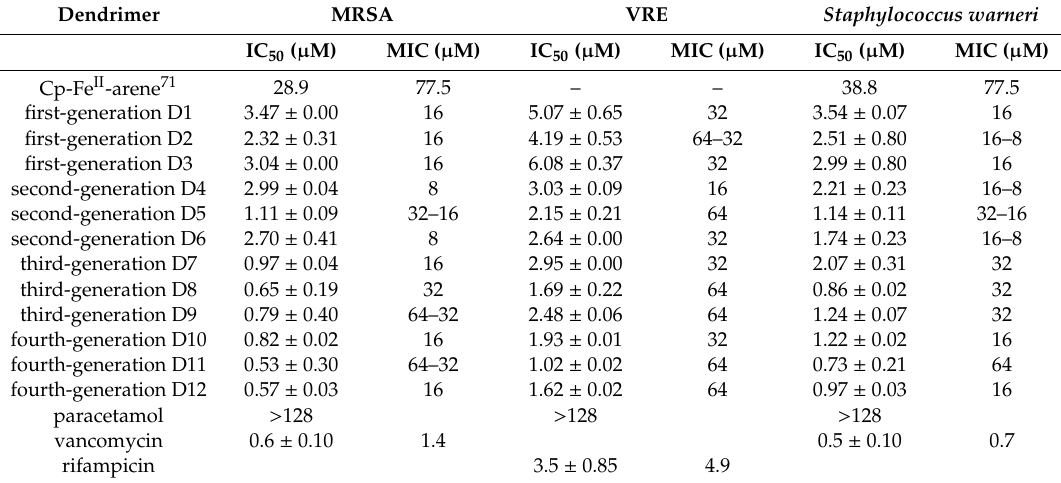
Table 3. Microbial activity of dendrimers D1 – D12